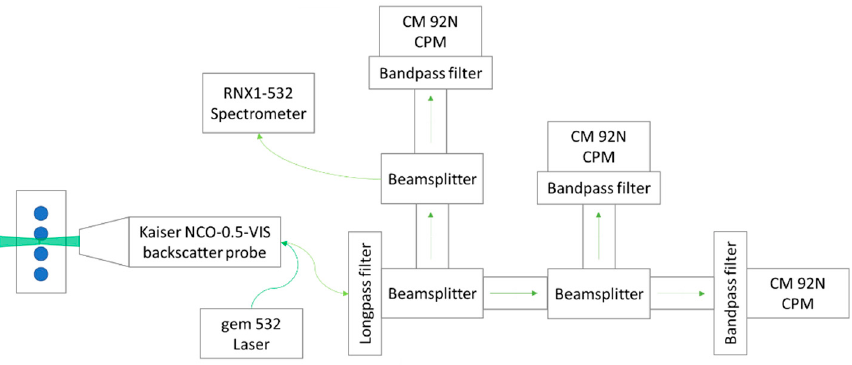
Figure 1. Schematic illustration of the measurement system. The focus is on the measurement technology components; details of the emulsification technology are not included.